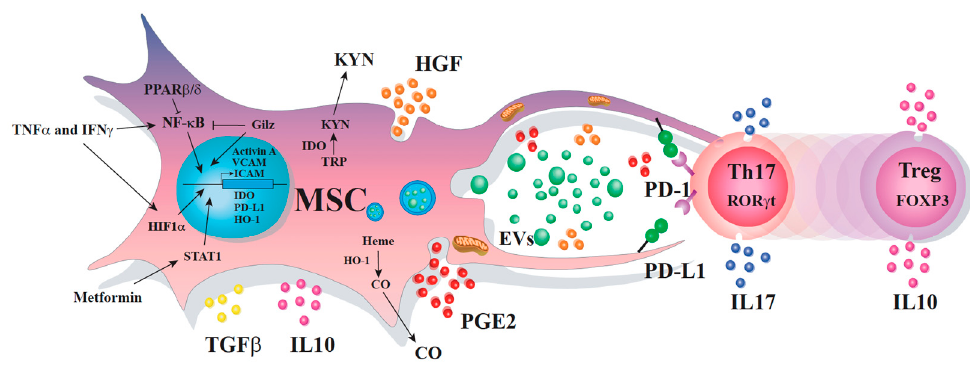
Figure 1. The multifaceted immunoregulatory dialogue between MSCs and Th17 cells. MSCs and Th17 cells communicate through many di ff erent ways that include the release of soluble factors, the transfer of mitochondria, the production of extracellular vesicles containing various molecules, and cell-to-cell contact. When MSCs and Th17 cells are near one another, they dialogue through the release of messengers including PD-L1, HGF, and PGE2 that are highly expressed when MSCs are co-cultured with Th17 cells. Moreover, MSCs (nearby Th17 cells) start to express high levels of IDO and HO-1, releasing some EV-containing immunoregulatory factors and transferring their mitochondrial via transient cell fusion and tunneling nanotubes. In return, Th17 cells start to express high levels of PD-1, exhibiting a reduced production of IL-17 and expression of ROR γ T, while increasing the capacity to release IL-10 and to express Foxp3. This type of signaling, in which MSCs and Th17 cells communicate over relatively short distances, regulates the phenotype and function of both cells.